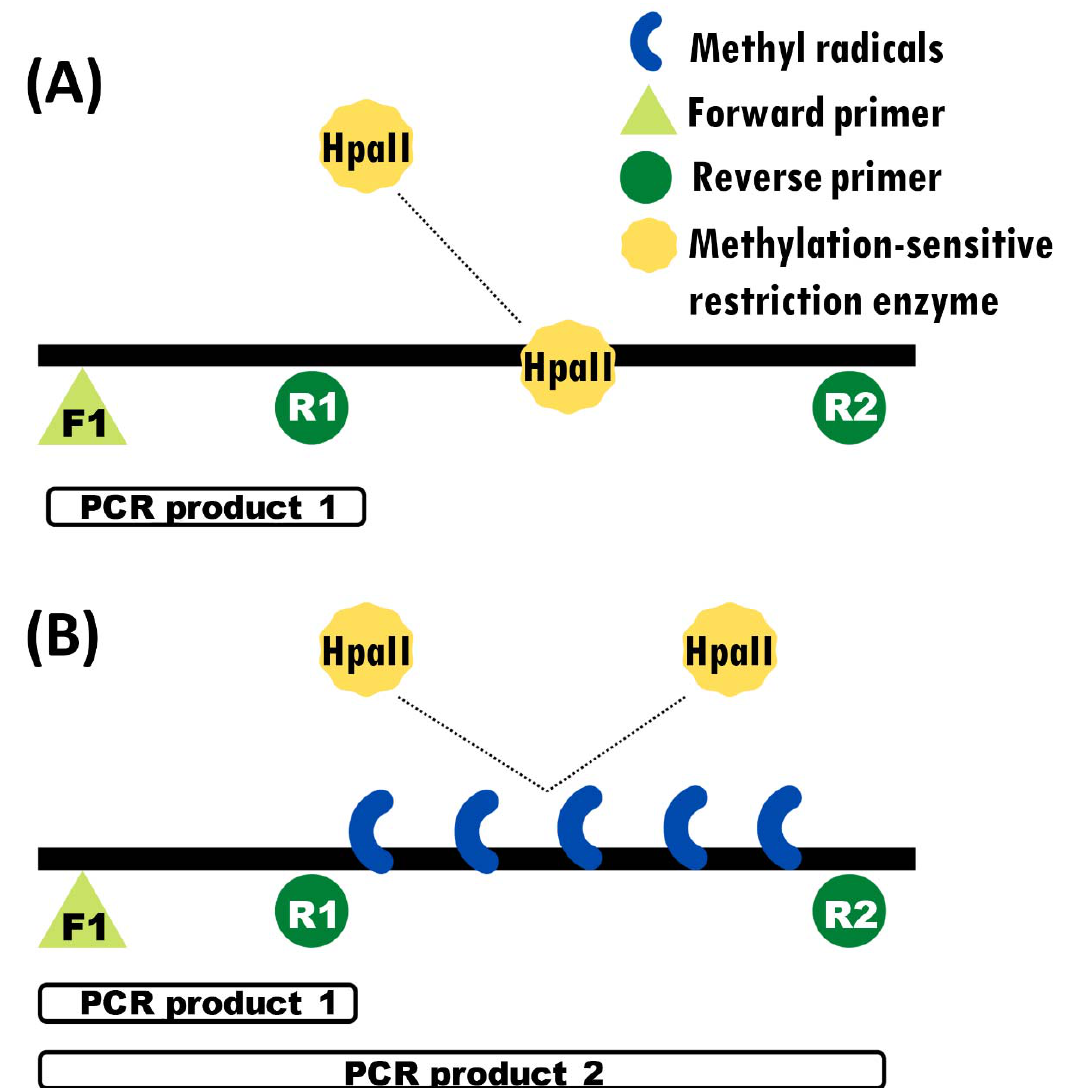
Figure 1. Experimental design of the methylation-sensitive PCR assay. Black bars denote the target DNA sequence, onto which the relative position of the primers, restriction sites, and methylation marks are illustrated. White bars denote the relative size of fragments amplified by PCR. ( A ) Amplification of only one PCR product due to the DNA digestion by HpaII. ( B ) Amplification of two